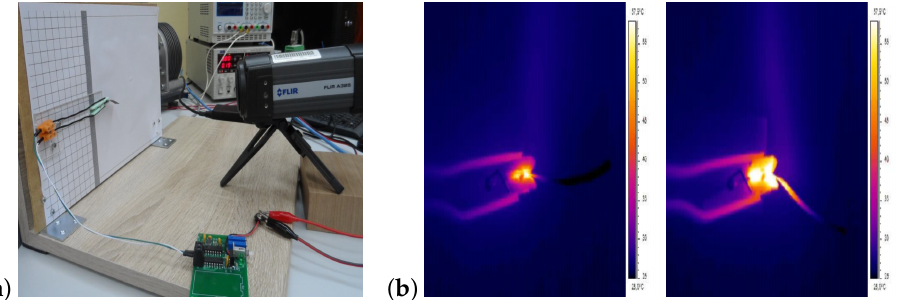
Figure 8. Implemented system with thermal imaging camera ( a ) and measurements carried out by thermal imaging camera for 20 and 60 s on strip ( b